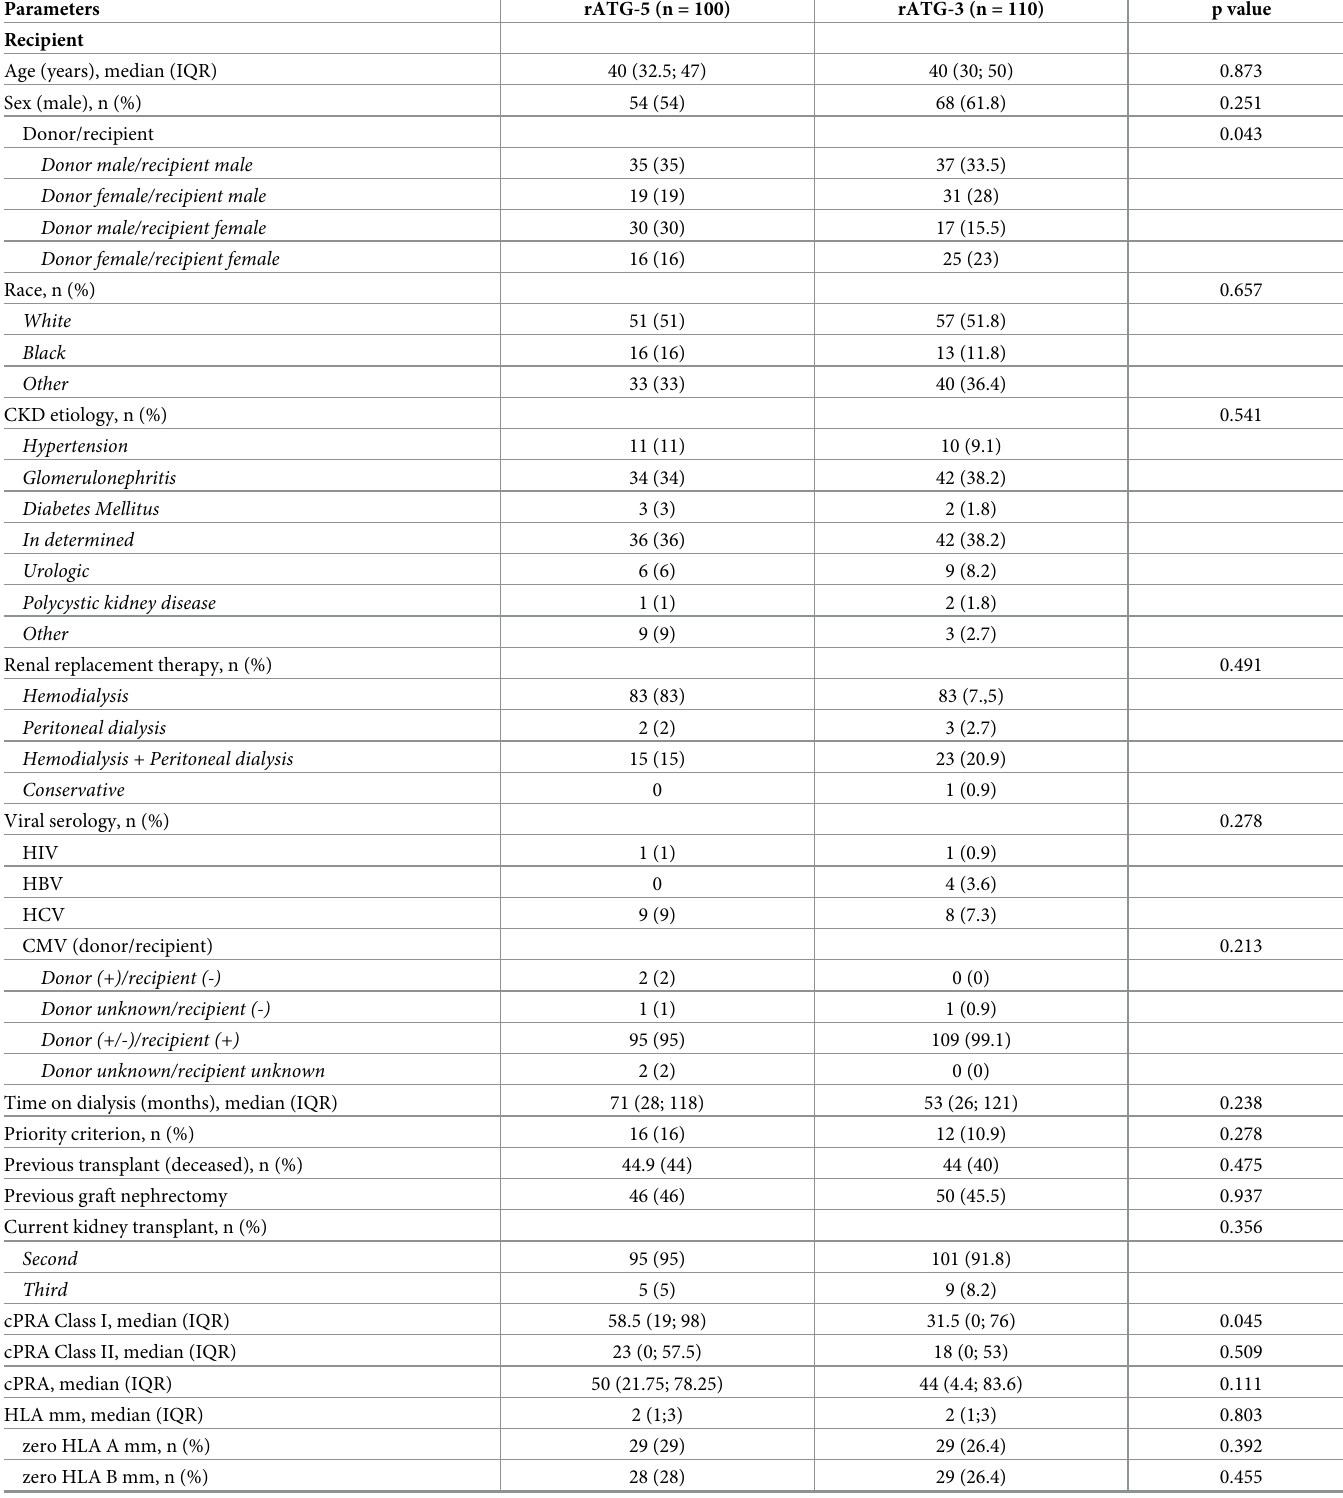
Table 1. Demographic characteristics of the study